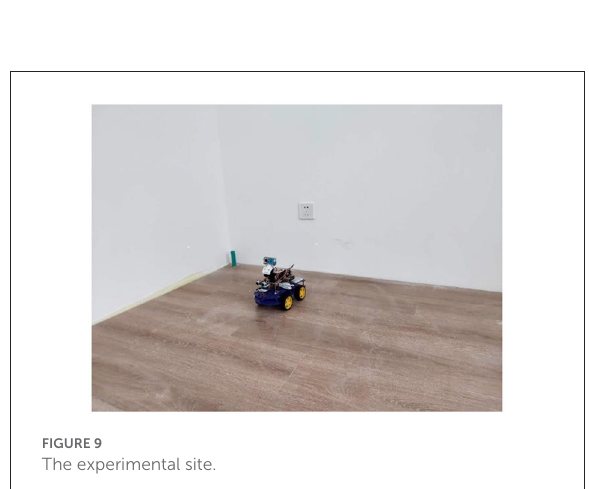
FIGURE9 The experimental